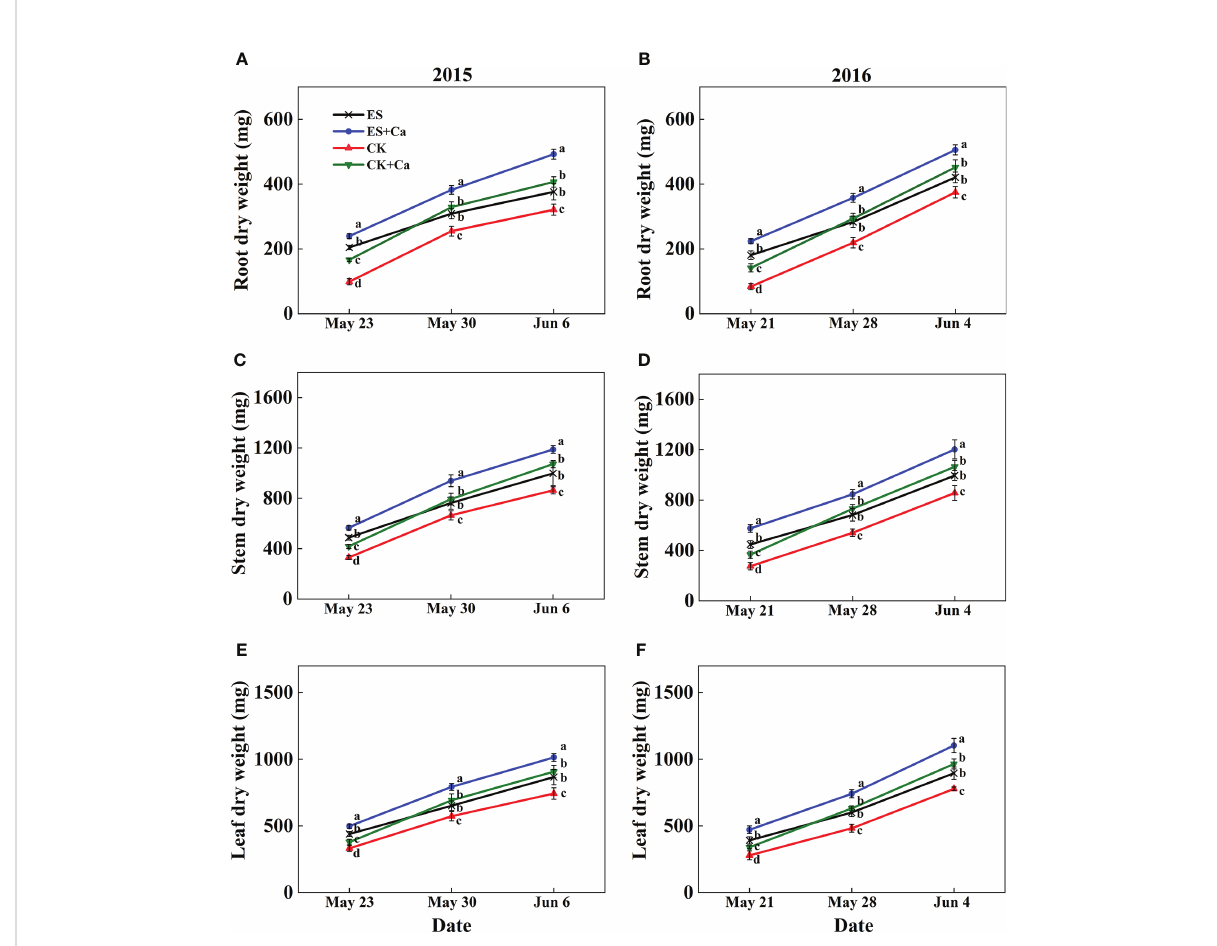
FIGURE 3 Effects of exogenous foliar calcium (Ca 2+ ) application on peanut root dry weight (A, B) , stem dry weight (C, D) , and leaf dry weight (E, F) under early and normal sowing scenarios. Values are means ± SD (n = 3). Different letters indicate signi fi cant differences according to Duncan ’ s multiple range tests ( p <